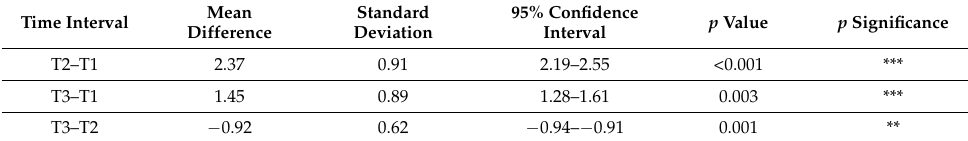
Table 9. Results of the mean differences (mm) of Nasal Floor 8 in the three time intervals.